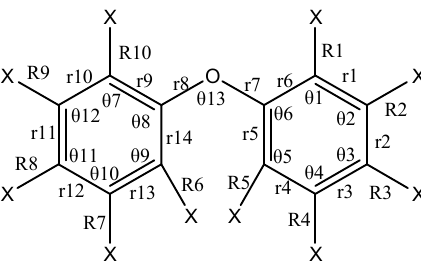
Figure 2. Atom numbering scheme for PBDEs (X = H or Br). Table 4. The structural parameters of the selected neutral PBDEs calculated at the B3LYP/6-311+G(d) level [ R (Å), r (Å), and θ (deg)].